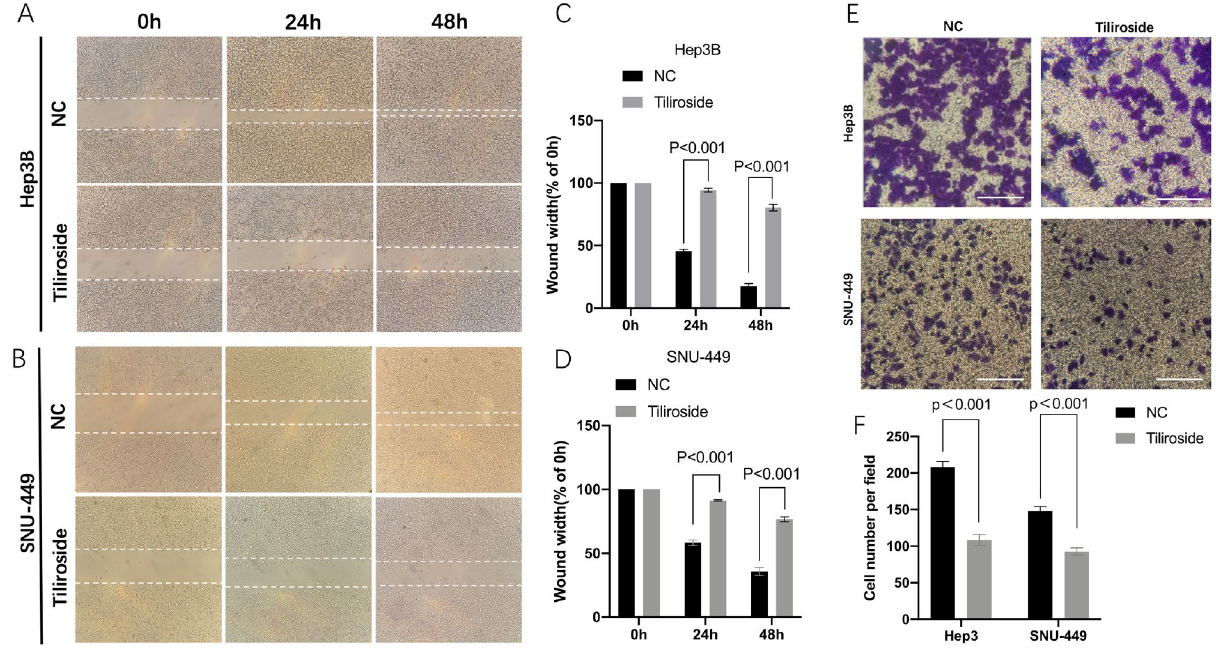
Figure 2. Tiliroside inhibited the migration and invasion abilities of Hep3B and SNU-449. The wound healing assay was made in Hep3B ( A ) and SNU-449 ( B ) treated by 40 μM Tiliroside or NC at 0, 24, 48 h, respectively. The bar graphics present the percentage of wound recovery in Hep3B ( C ) and SNU-449 ( D ). Cell wounds healed significantly faster in NC groups than those in Tiliroside group. Transwell chamber invasion assay for Hep3B and SNU-449 cells intervened by Tiliroside , and NC. Images were taken after 24 h or 12 h incubation. The average of cell number was counted by 3 randomly chosen different fields in both Hep3B and SNU-449 cells ( E , F ). Values represent the mean ± SD. NS non-significant, NC negative